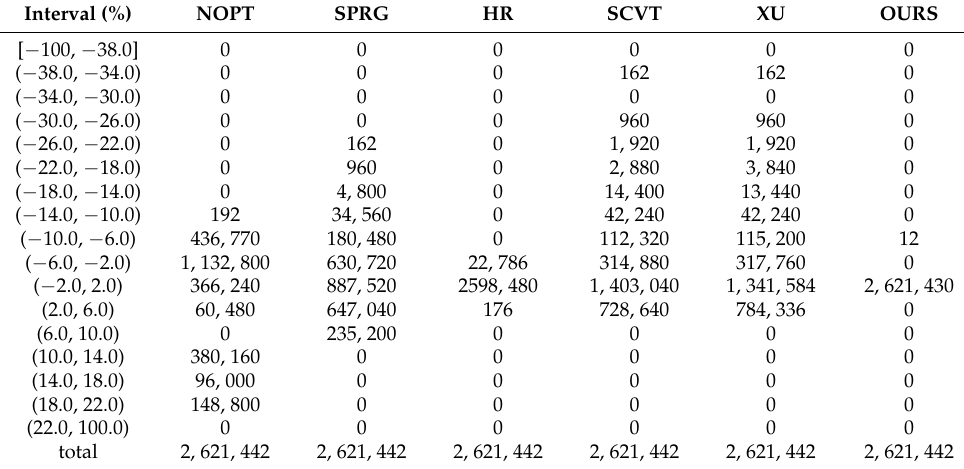
Table 3. The number of grids in different D area interval of different